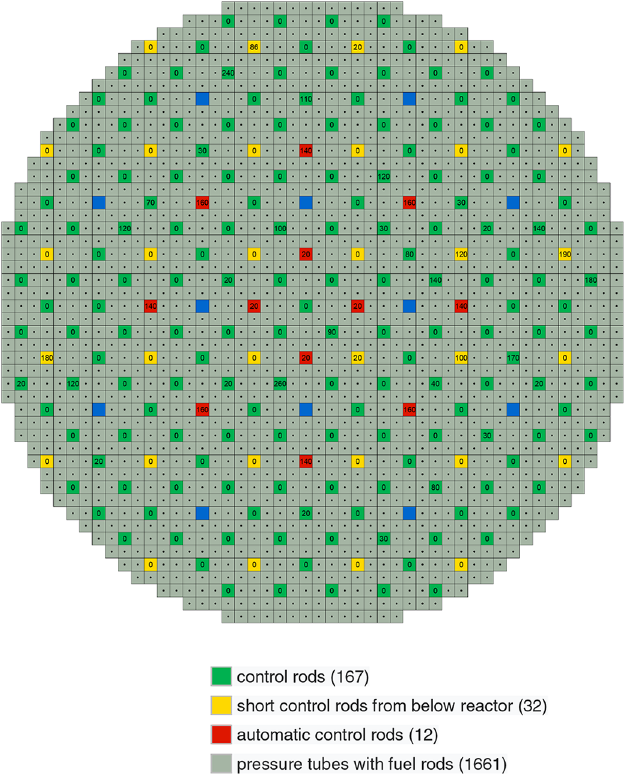
Fig. 1. Schematic view of the core (from